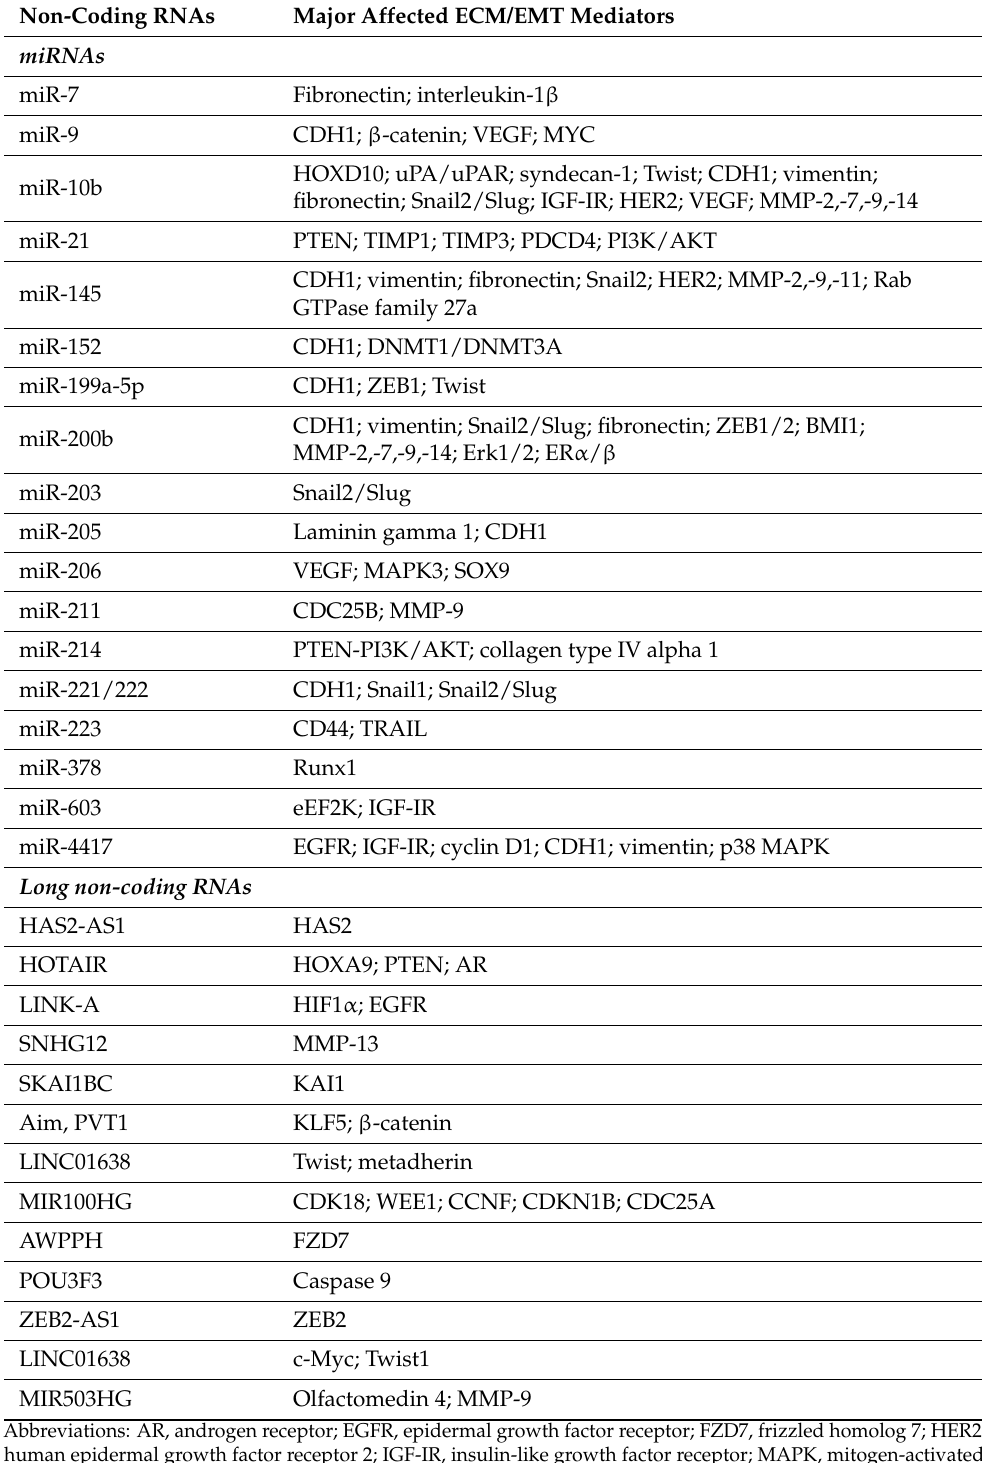
Table 1. Major non-coding RNAs (miRNAs and long non-coding (lnc)RNAs) and their ECM/EMT- related targets.